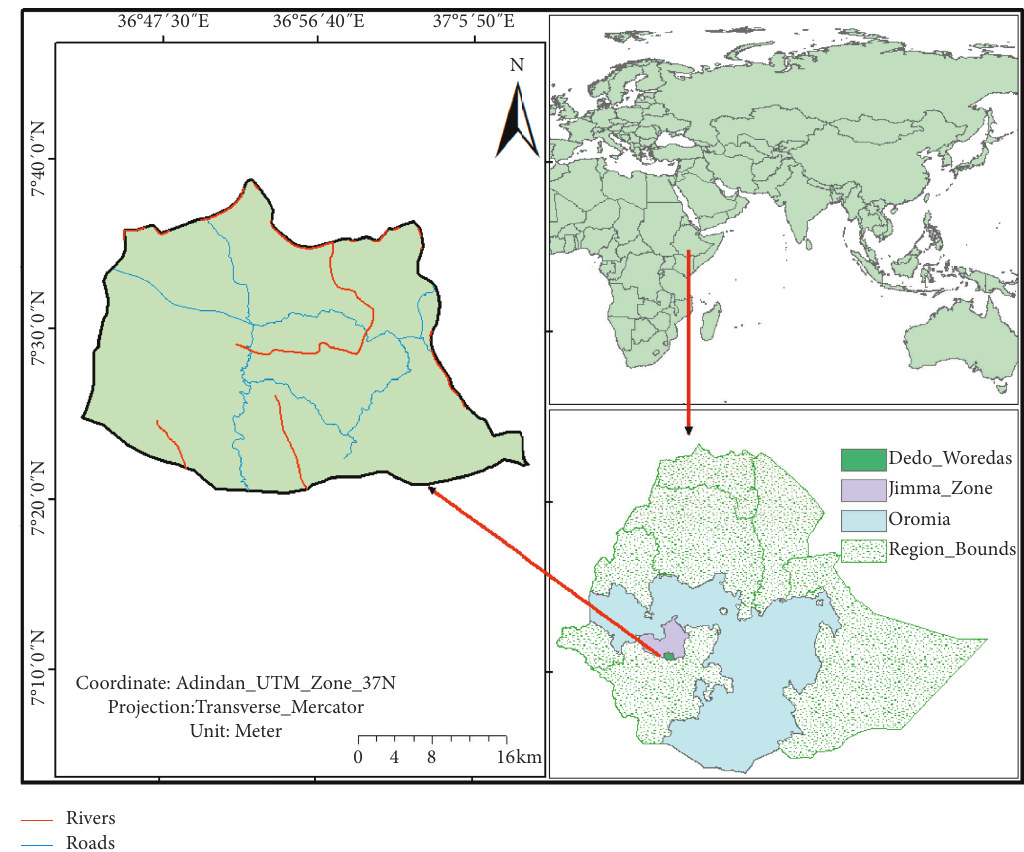
Figure 1: Map of the study